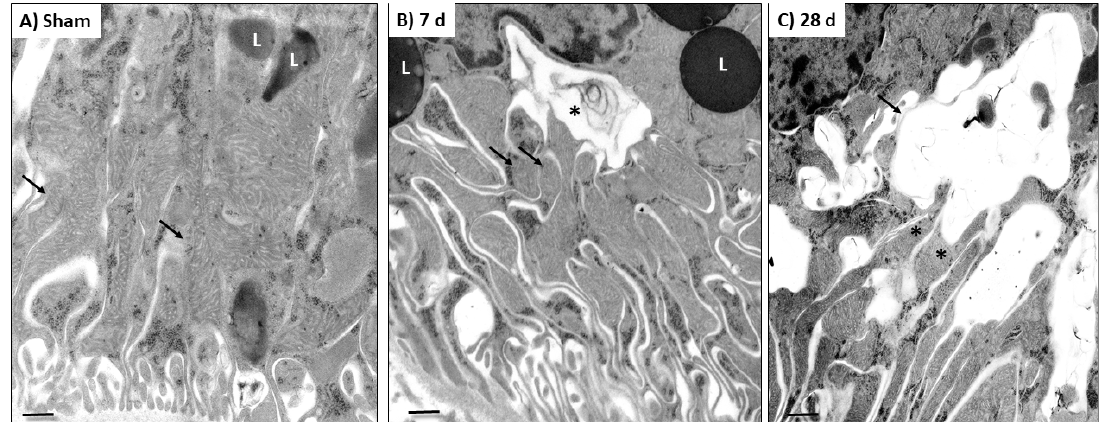
Figure 4. Representative ultrastructural micrographs of epithelial cells from proximal convoluted tubules in ( A ) sham animals and in ( B , C ) rats with 5/6 nephrectomy (5/6Nx). ( A ) Normal appearance of the mild and basal cytoplasmic areas of an epithelial tubular cell from a sham animal, showing long mitochondria (arrows) and round electron dense lysosomes (L). ( B ) After 7 days (d) of 5/6Nx, there were small and round mitochondria (arrows) and large cytoplasmic vacuoles limited by a double membrane corresponding to autophagosomes (asterisk), which were near to mitochondria and large lysosomes (L). ( C ) After 28 days of kidney resection, these cytoplasmic double-membrane vacuoles (arrow) were larger and directly connected to mitochondria (asterisks). Scale magnification bar = 500 nm.